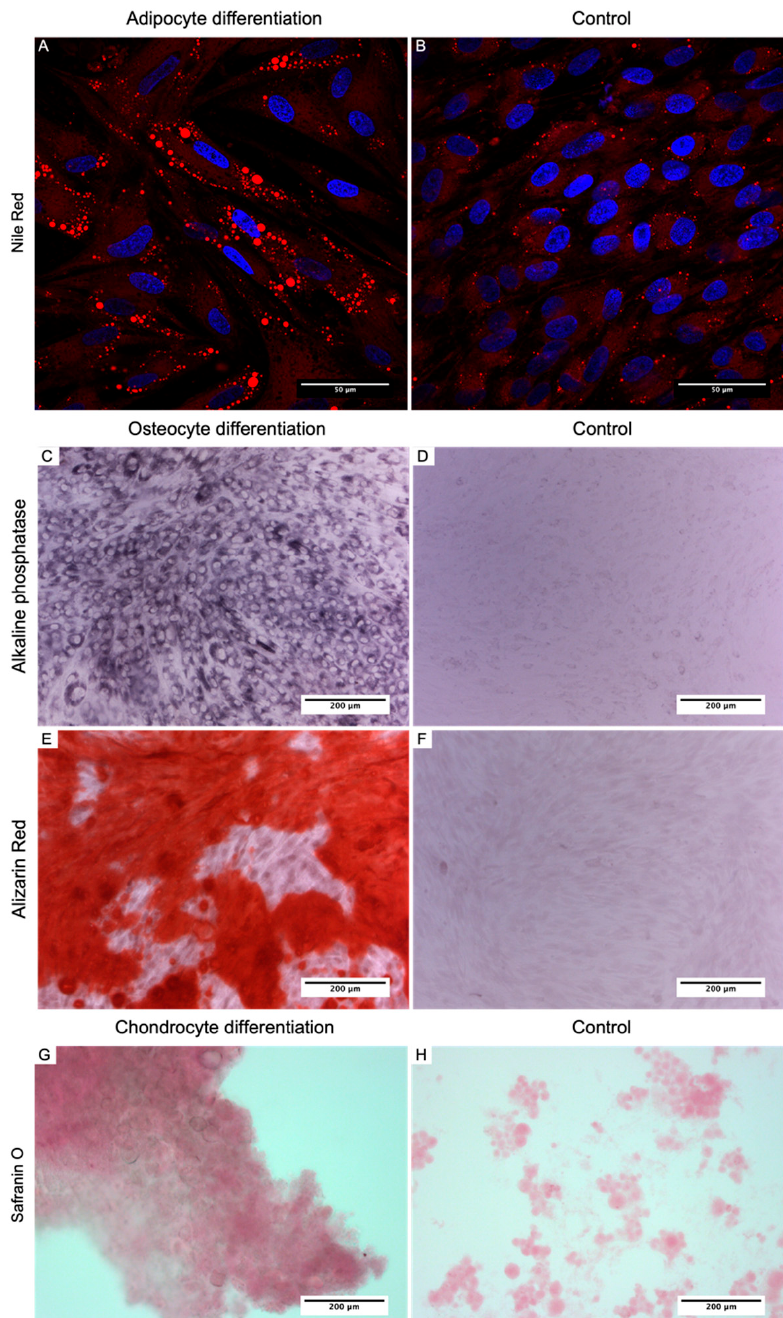
Figure 4. ( A , B )—confocal images of L-MSCs-EGFP stained with Nile Red. The nuclei were counterstained with DAPI. Scale bar 50 μ m. ( A ) L-MSCs-EGFP after 3 weeks induction in adipogenic media. ( B ) L-MSCs-EGFP control cells. ( C , D ) light microscopy of L-MSCs-EGFP stained for alkaline phosphatase (Scale bar 200 μ m). ( C ) L-MSCs-EGFP after 3 weeks of induction in chondrogenic media. ( D ) control cells. ( E , F ) light microscopy of L-MSCs-EGFP stained with Alizarin Red (Scale bar 200 μ m). ( E ) L-MSCs-EGFP after 3 weeks of induction in chondrogenic media. ( F ) control cells. ( G , H ) light microscopy of L-MSCs-EGFP micromasses stained with Safranin O (Scale bar 200 μ m). ( G ) micromass of L-MSCs-EGFP after 2 weeks of induction in chondrogenic media. ( H ) control cells.